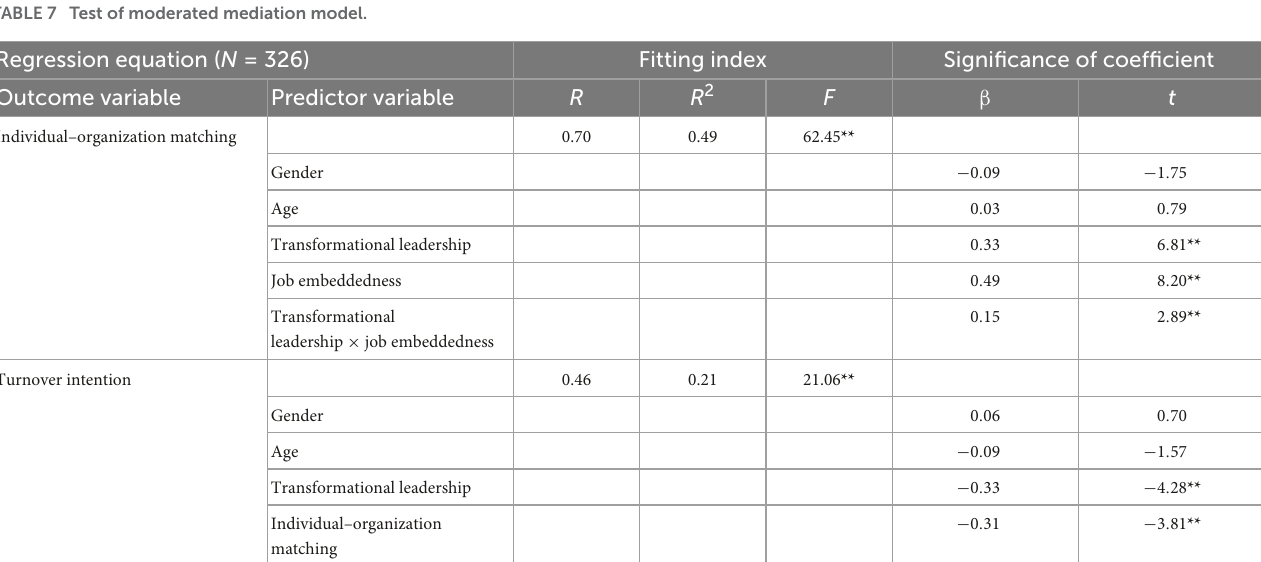
TABLE 7 Test of moderated mediation model. Regression equation ( N =